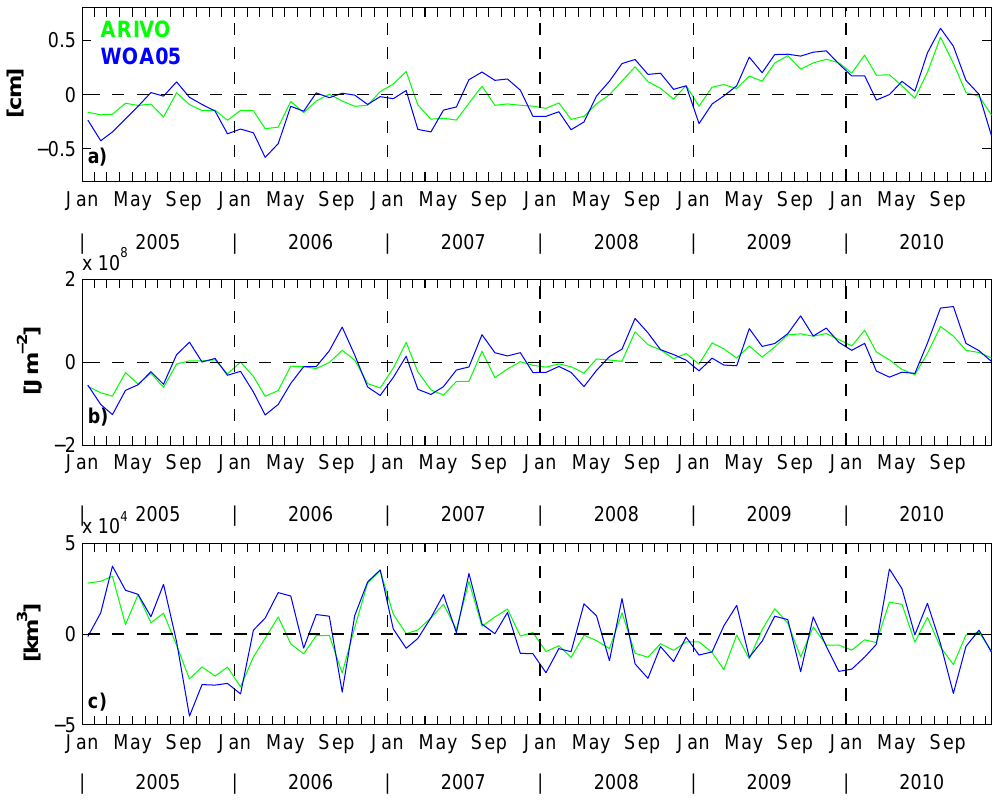
Fig. 2. Sensitivity test to estimate the climatology uncertainty for (a) GSSL, (b) GOHC and (c) GOFC during 2005–2010. To fill gaps at depth as well as to evaluate anomaly fields, two different climatologies are used, i.e. either ACLIM (green) or WOA05 (blue, see text for more details).